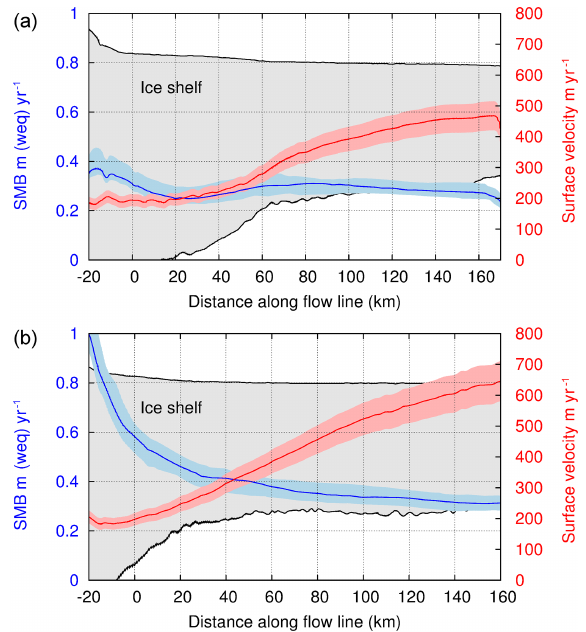
Figure 4. Along-flow profiles of surface mass balance and veloc- ity used for (a) the Cabinet Inlet trajectory and (b) the Whirlwind Inlet trajectory. The shaded boundaries represent the uncertainty es- timates as described in the text. See Fig. 5a and b for the scale for the grey-shaded ice-shelf outlines.